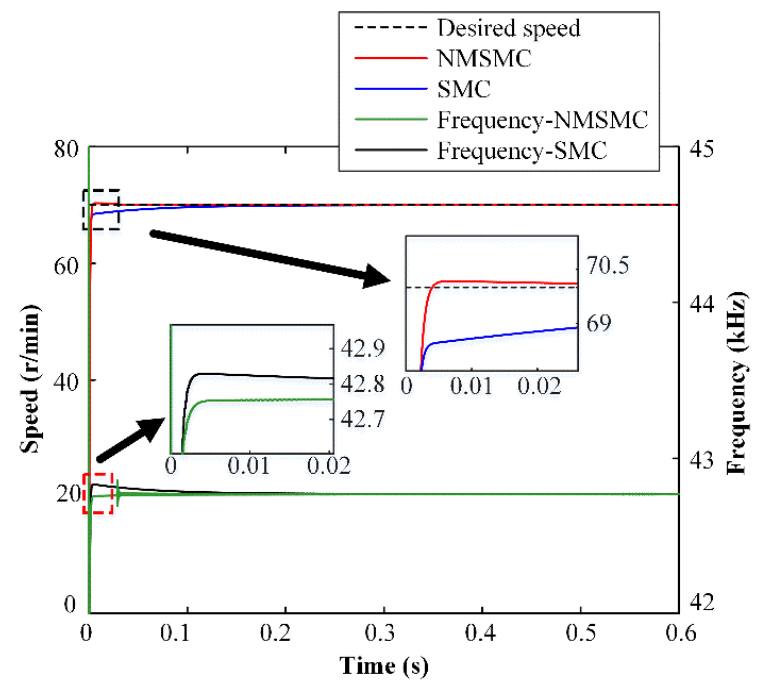
Figure 6. Simulation results of constant speed control for SMC and NMSMC.